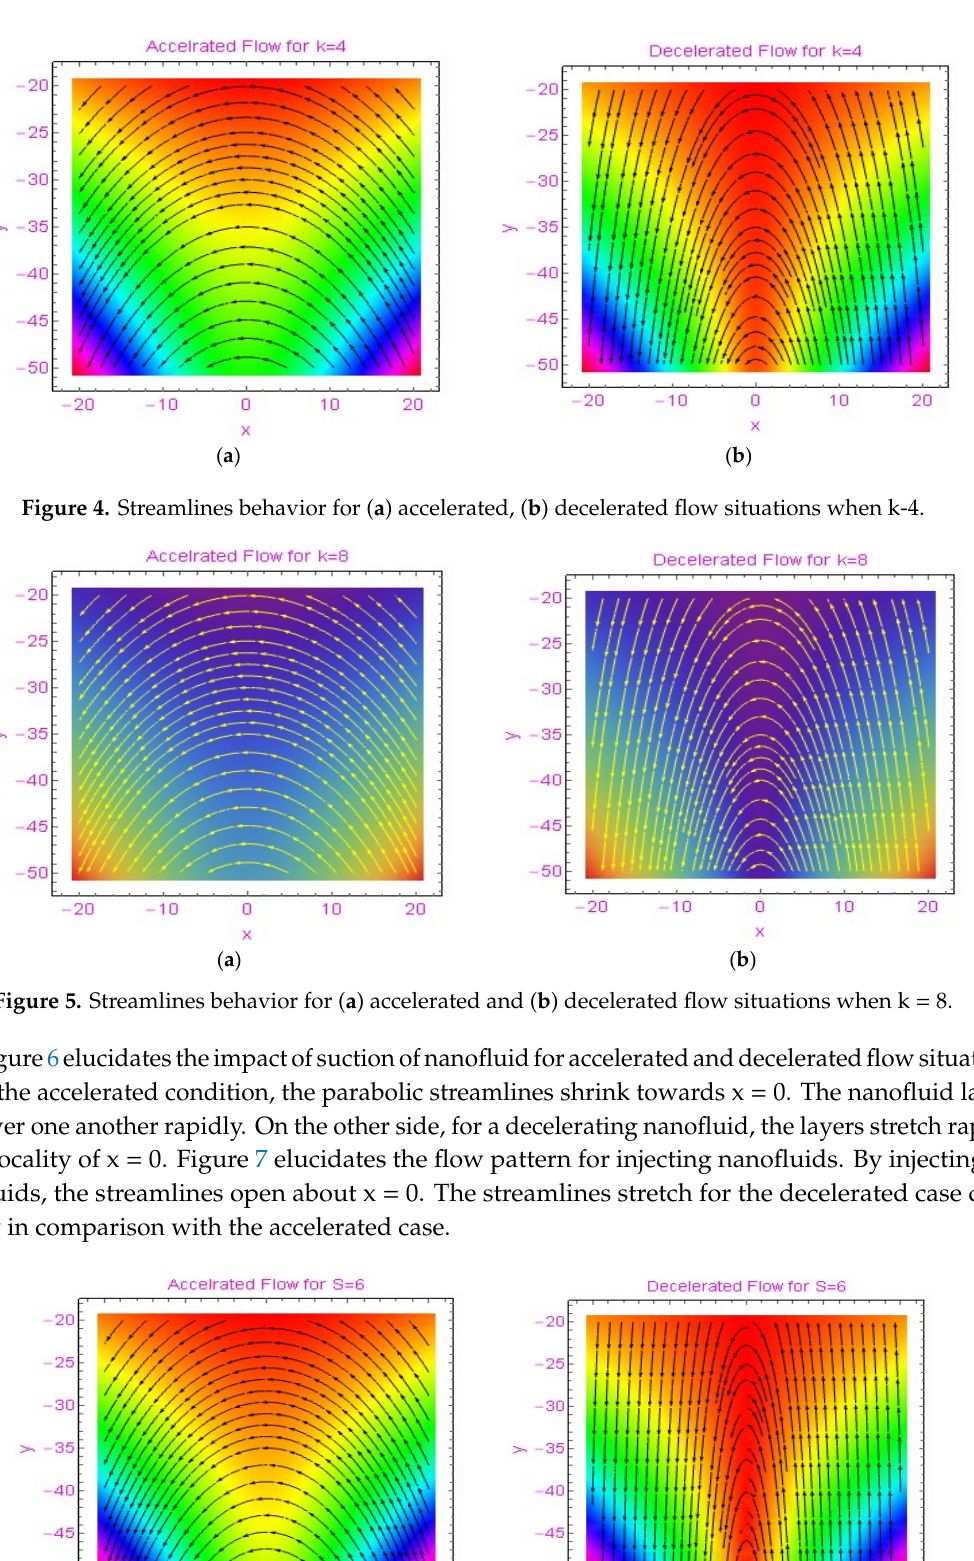
( a ) ( b ) Figure 7. Streamlines behavior for ( a ) accelerated and ( b ) decelerated flow situations when S = −6 .